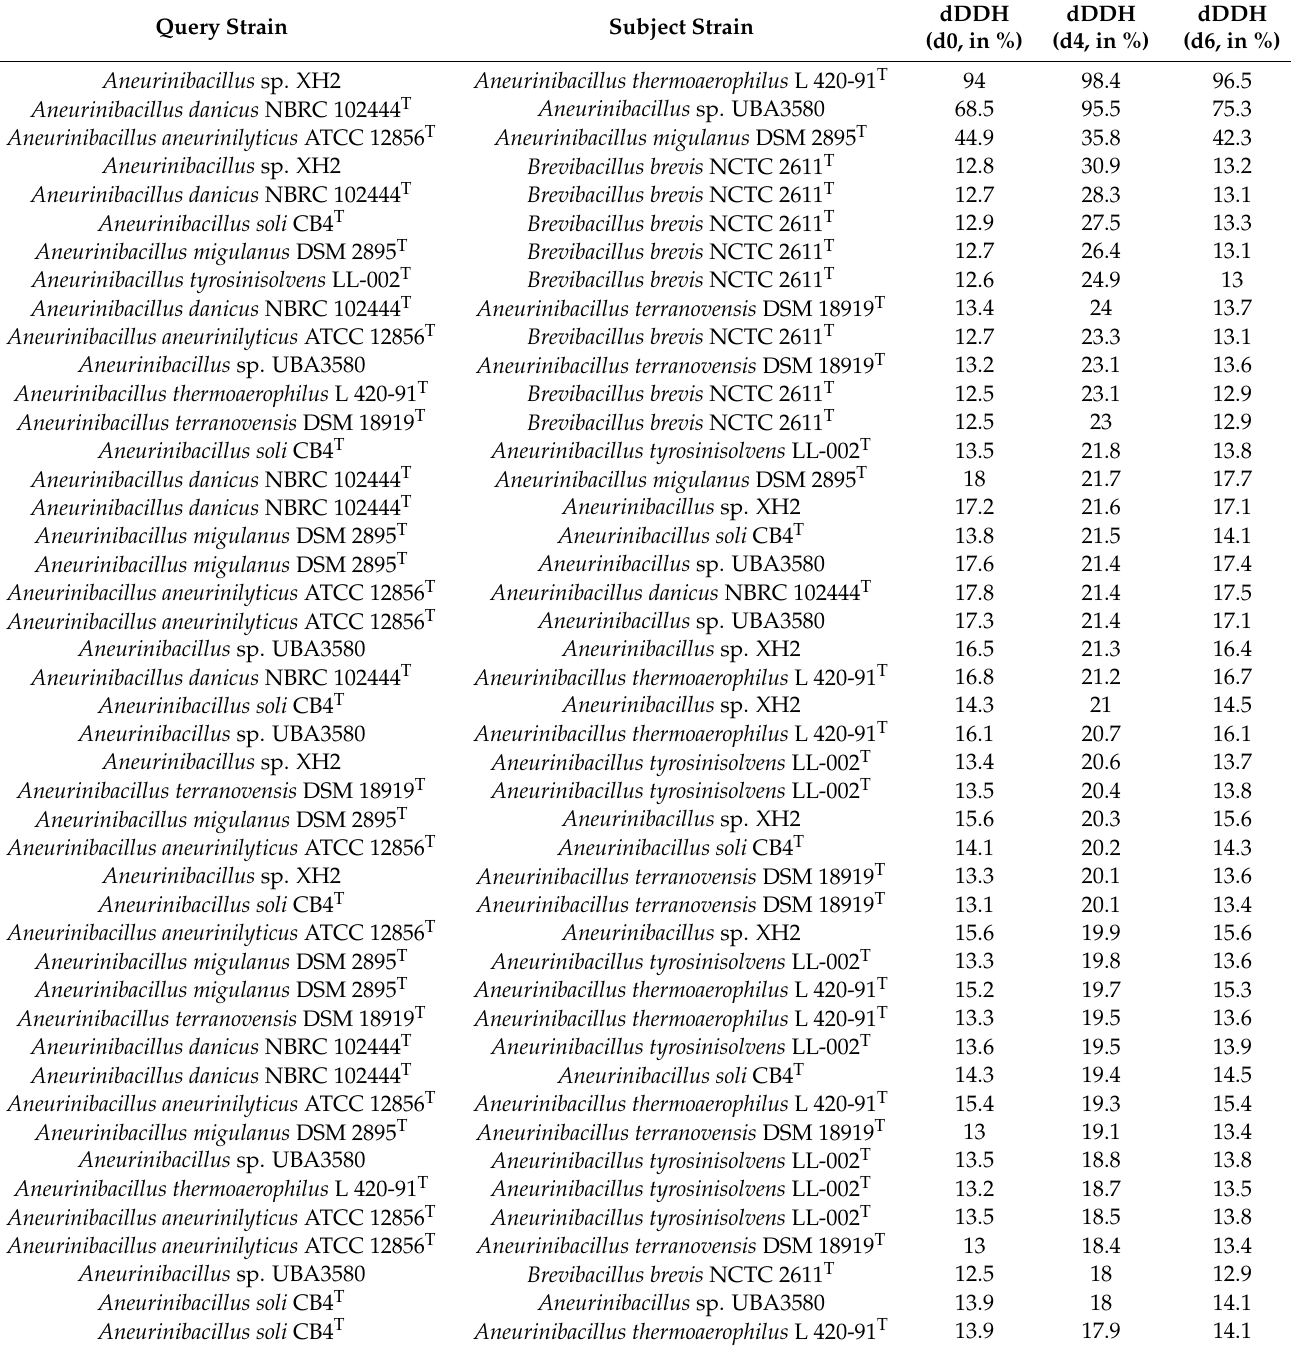
Table 2. Pairwise comparisons of dDDH values between nine Aneurinibacillus genomes. The values are based on three different GBDP formulas: d0 (length of all HSPs divided by total genome length); d4 (sum of all identities found in HSPs divided by overall HSP length); d6 (sum of all identities found in HSPs divided by total genome length). Genome of Brevibacillus brevis NCTC 2611 T was used as an